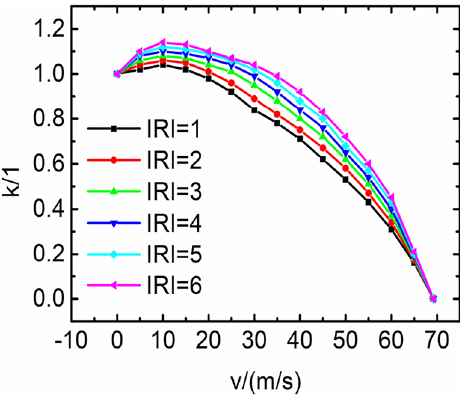
Fig. 3 Dynamic load coefficient influenced by IRI and v